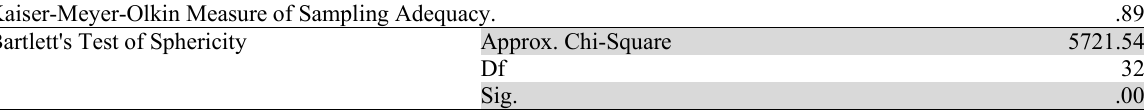
KMO and Bartlett's Test Kaiser-Meyer-Olkin Measure of Sampling Adequacy. .891 Bartlett's Test of Sphericity